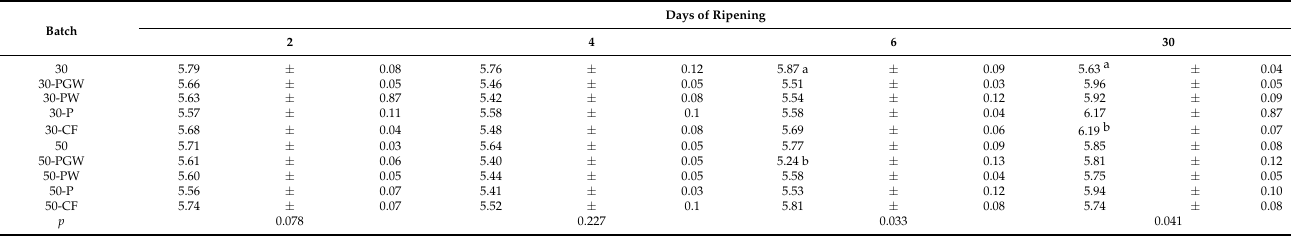
Table A2. pH values on day 2, 4, 6 and 30 of ripening (mean ± SE) (1)